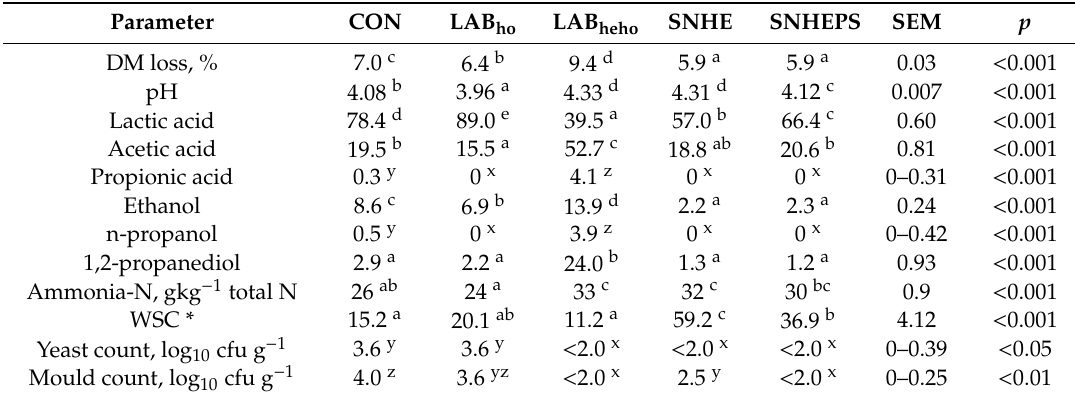
Table 3. E ff ects of additive type and composition on dry matter (DM) losses, fermentation characteristics and fungal populations of early-cut rye silage stored for 64 days (data presented as LSmeans in g kg − 1 DM unless stated otherwise, n = 3).